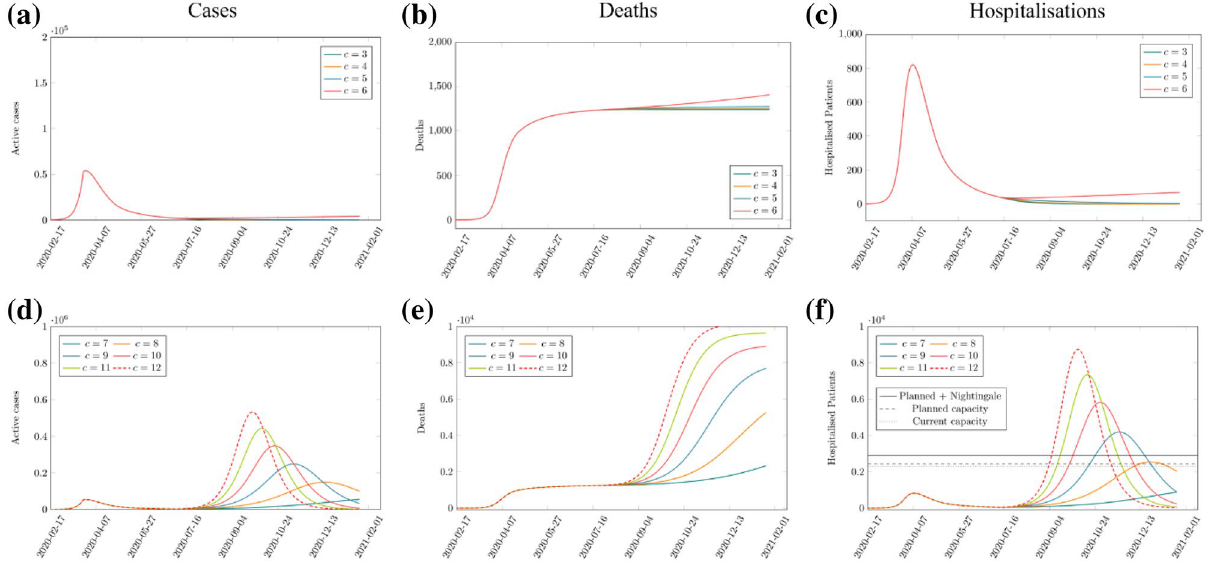
Figure 3. Projections of the mathematical model forecasting the number of COVID-19 cases (left panels), deaths (centre panels) and hospitalised patients (right panels) for varying numbers of daily contacts, c . ( a )–( c ) show high levels of social distancing, c = 3 to 6, and ( d )–( f ) show low social distancing, c = 7 to 12. Infectiousness period = 5 days, proportion of symptomatic infections = 70%. Estimates for hospital capacity levels are given in ( f ) for